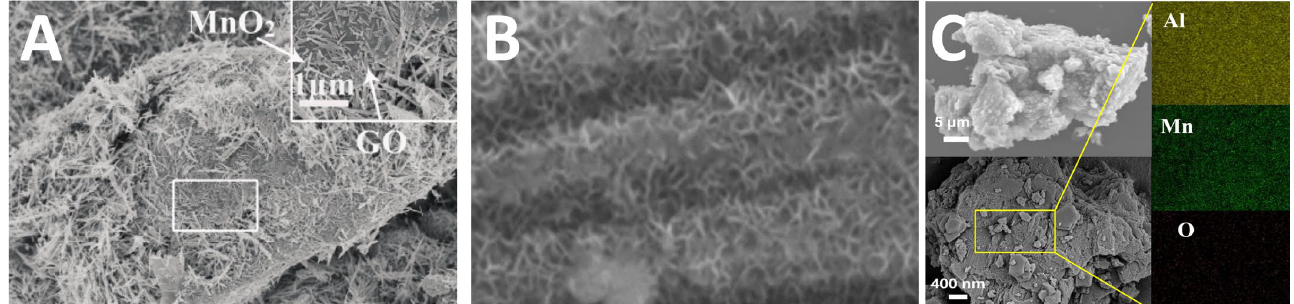
Figure 2. Samples of MnOx immobilized catalysts for catalytic ozonation. ( A ) MnO 2 immobilized graphene oxide; ( B ) MnO 2 immobilized carbon microfibers and ( C ) MnO 2 immobilizedγ -Al 2 O 3 . Reproduced with permission from Refs. [40–42].